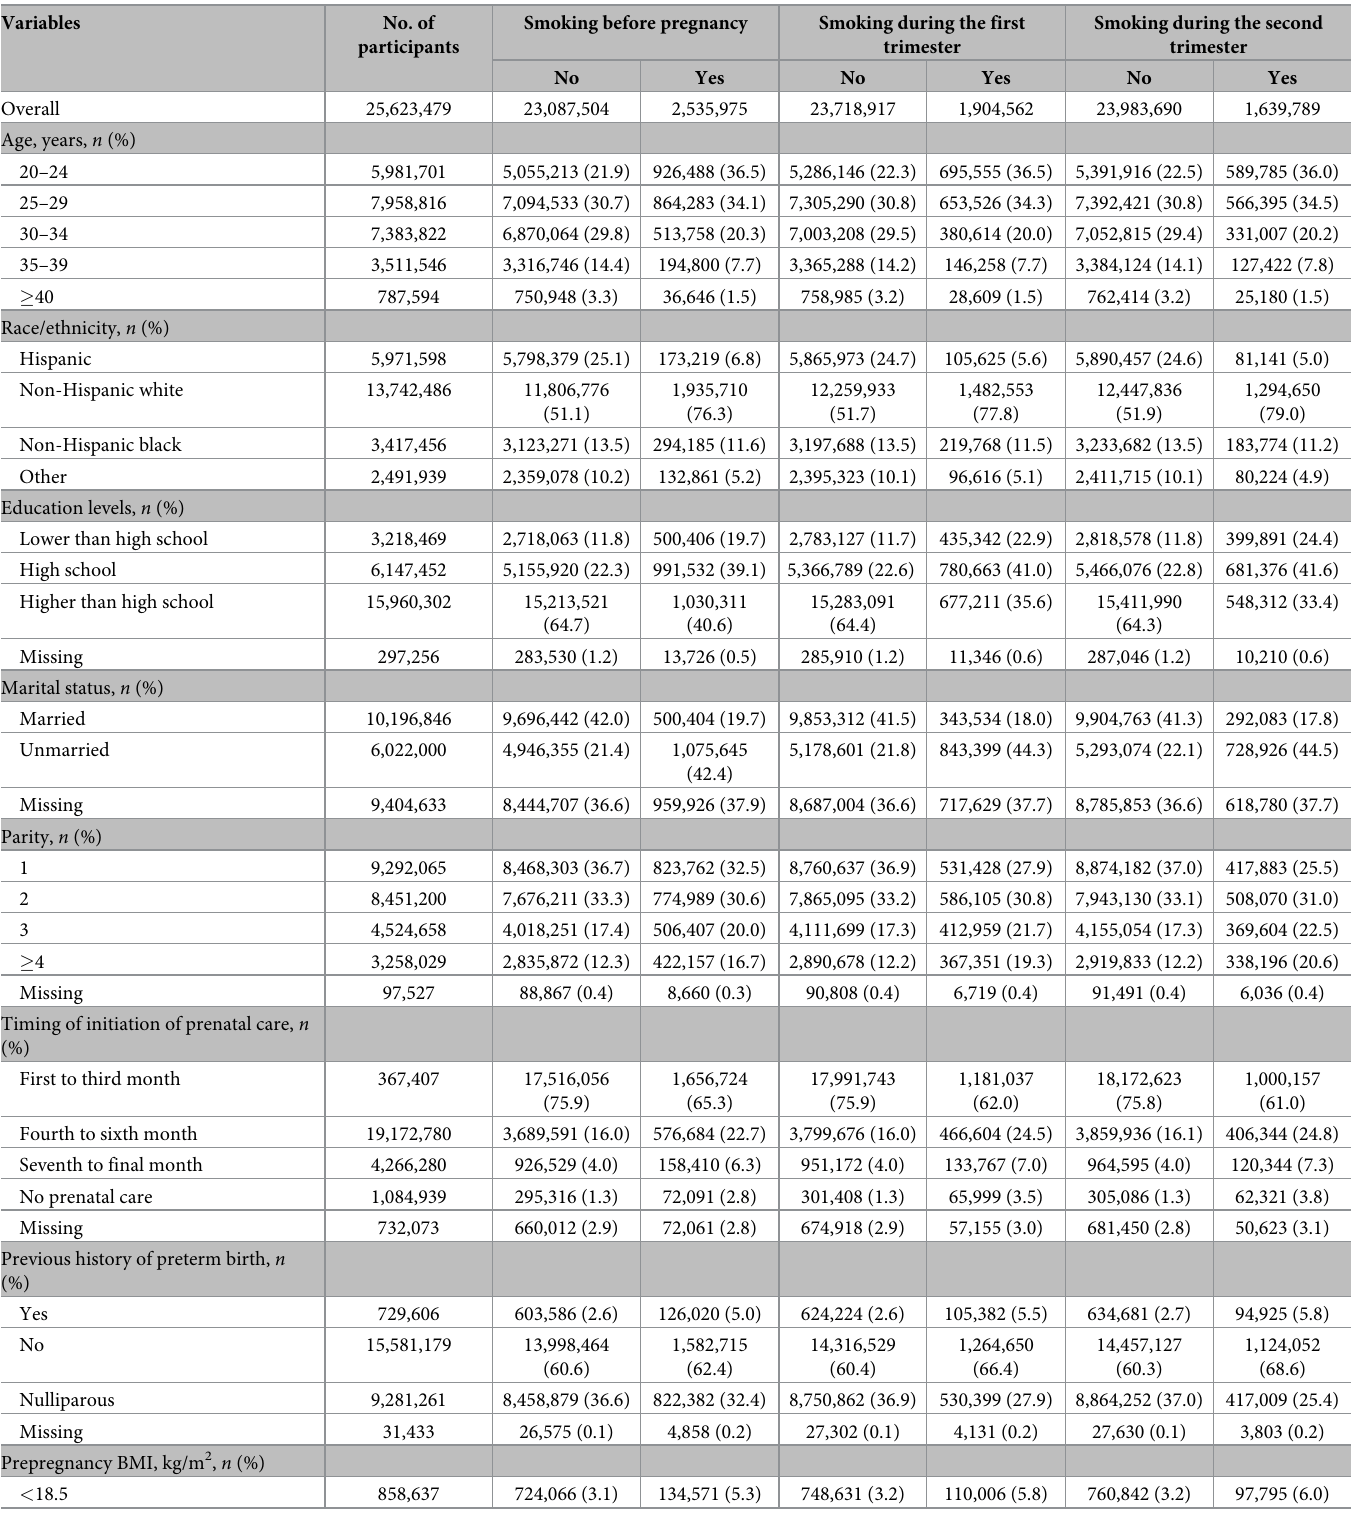
Table 1. Population characteristics according to maternal smoking before and during